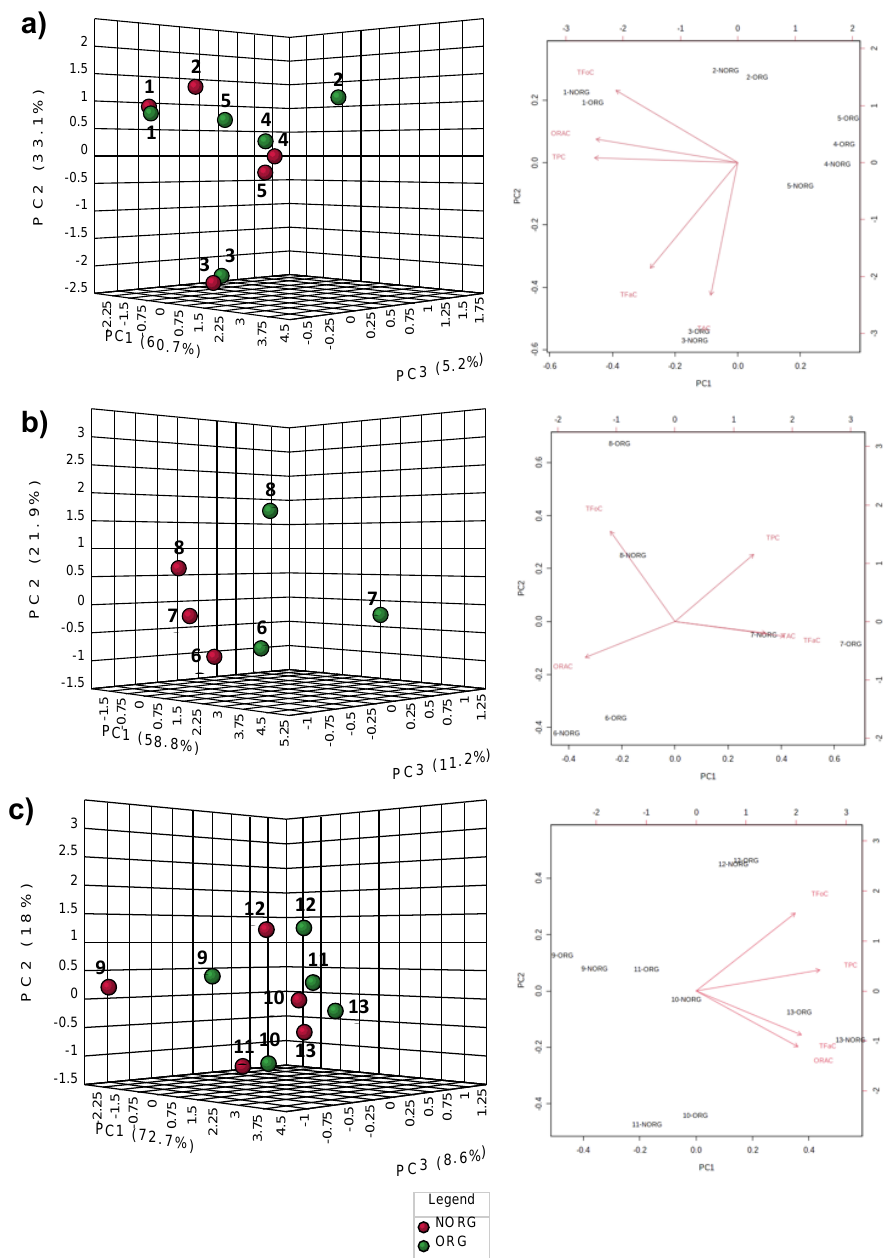
Figure 4. Patterns of separation between organically (ORG) and non-organically (NORG) grown plant-based foods across the three groups of samples. The figures correspond to PCA score plot: ( a ) PCA results of fruits samples. ( b ) PCA results of vegetables samples. ( c ) PCA results of nuts and legume samples. The number of data points corresponds to each sample: 1. Olive, 2. Orange, 3. Sweet cherry, 4. Tomato E., 5. Tomato T., 6. Onion, 7. Sweet pepper, 8. Swiss chard, 9. Almond, 10. Hazelnut C., 11. Hazelnut N., 12. Walnut, 13. Carob pods. Abbreviations: PCA, principal component analysis; PC, principal component.